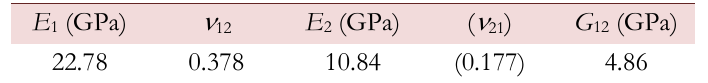
Table 1: Elastic constants of IMP.